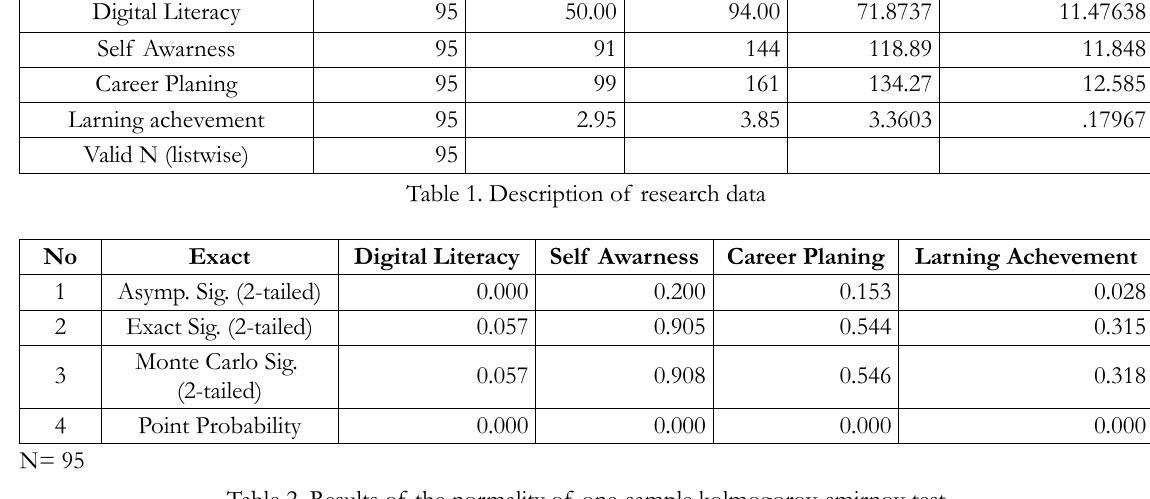
Table 2. Results of the normality of one-sample kolmogorov-smirnov